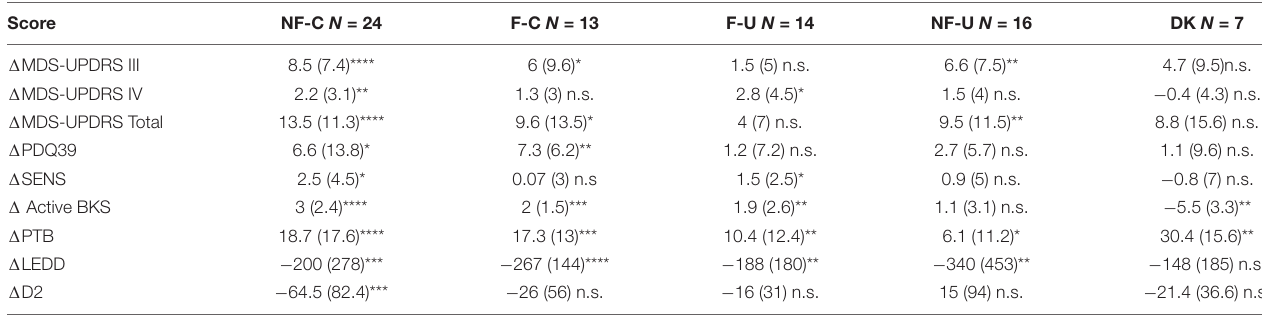
FIGURE 3 | This figure is based on the assumption that the aim of therapy is to convert fluctuators into Non-fluctuators Controlled category or a category as near as possible to controlled. This figure aims to provide a pictographic representation of the relative success in achieving this for subjects who, at the start of the study, were in one of the three “uncontrolled” categories, and subgrouped according to whether they were in the PKG- or PKG + arm. Panel (A) shows the 28 participants who were in the Fluctuator–Controlled (F-C) category at the start of the study with those in the PKG- arm depicted by the right Column and those in the PKG + arm by the left column. Each column is divided into segments whose color represents a fluctuator state, with the legend on the left of the figure, where P-D DK represents “Peak dose dyskinesia” and Global DK represents “global dyskinesia” or dyskinesia throughout the whole day. The size of each colored segment and the percentage within each segment of the column indicates the proportion of participants in that color coded category at study end. Panel (B) is a similar plot for participants who were in Fluctuator –Uncontrolled (F-U) at the start of the study. Panel (C) is a plot of the outcome of participants who were in Non-fluctuator –Uncontrolled (NF-U) at the start of the study. TABLE 3 | Changes in Clinical according to the fluctuator category reached at end of study.